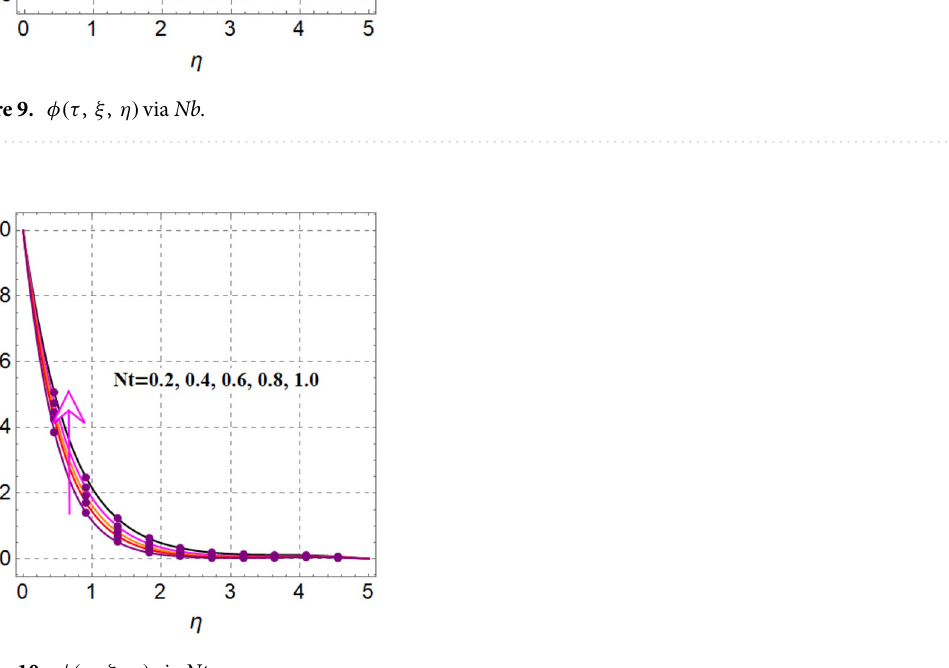
Figure 10. φ(τ , ξ , η) via Nt